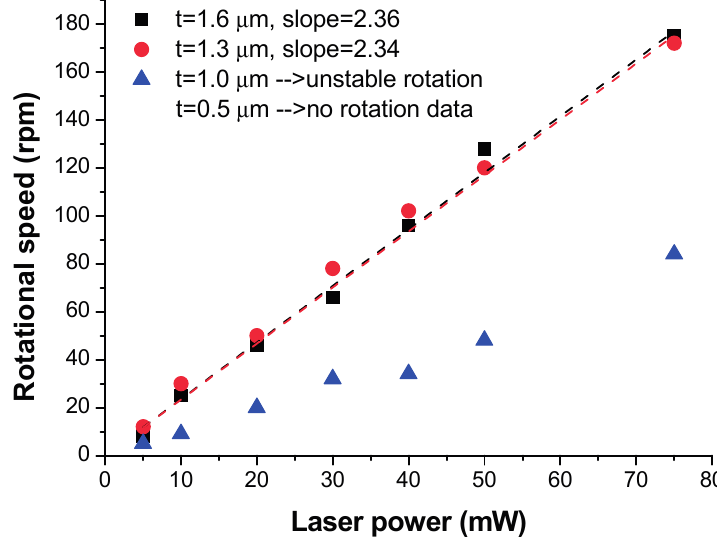
Figure 6. The evolution of rotational speeds under increasing laser power for micro-crews with different blade thicknesses ( t = 0.5 μ m, 1.0 μ m, 1.3 μ m, and 1.6 μ m).